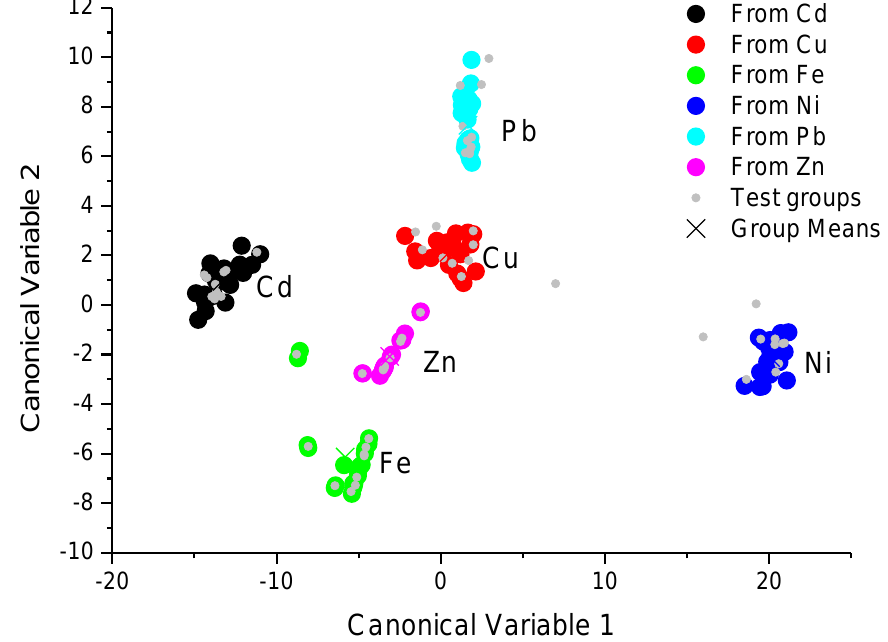
Figure 4. The canonical score plots for the training and testing processes built from the set of spectra data which were obtained with the Ultravioled-visible (UV-VIS) bench spectrometer. The classification procedure was obtained by using the linear discriminant analyses.